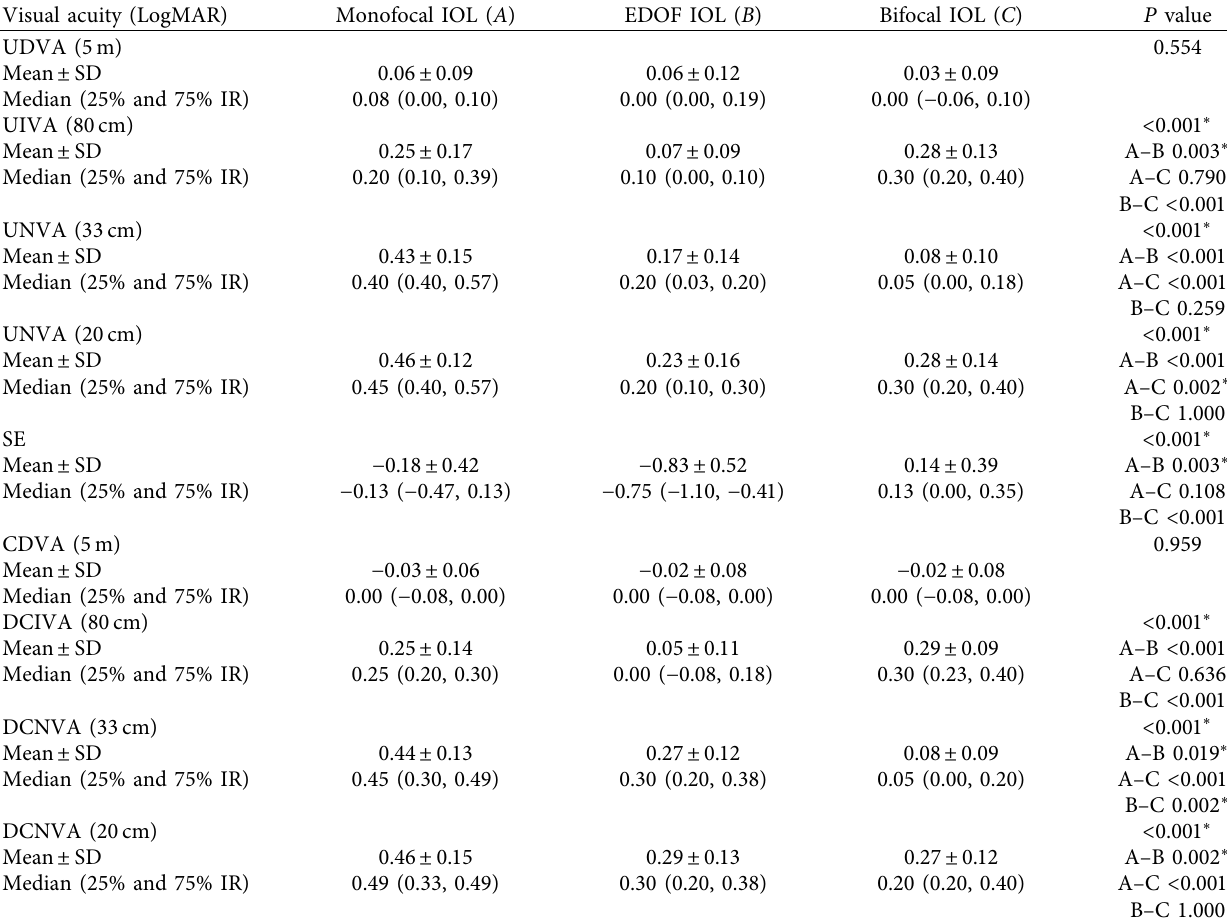
Table 2: Intragroup comparison of visual outcomes in the 3 IOL